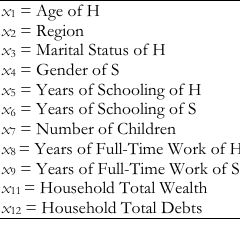
Formative indicators for HC estimation (Dagum and Slottje,